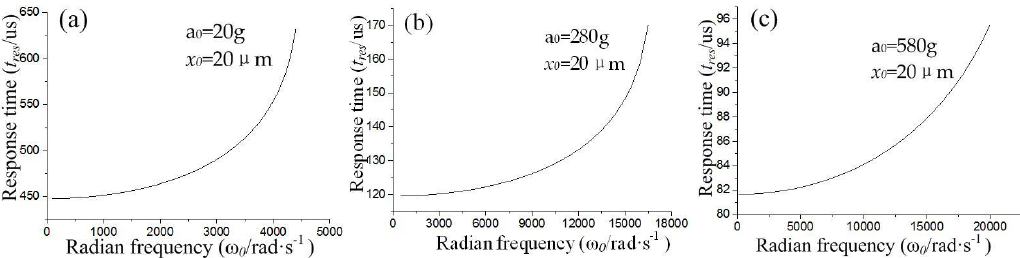
Figure 3. Relation curves of response time ( t re ) between inherent frequency ( ω 0 ). ( a ) the inertial switch with threshold is 20 g, ( b ) 280 g, ( c ) 580